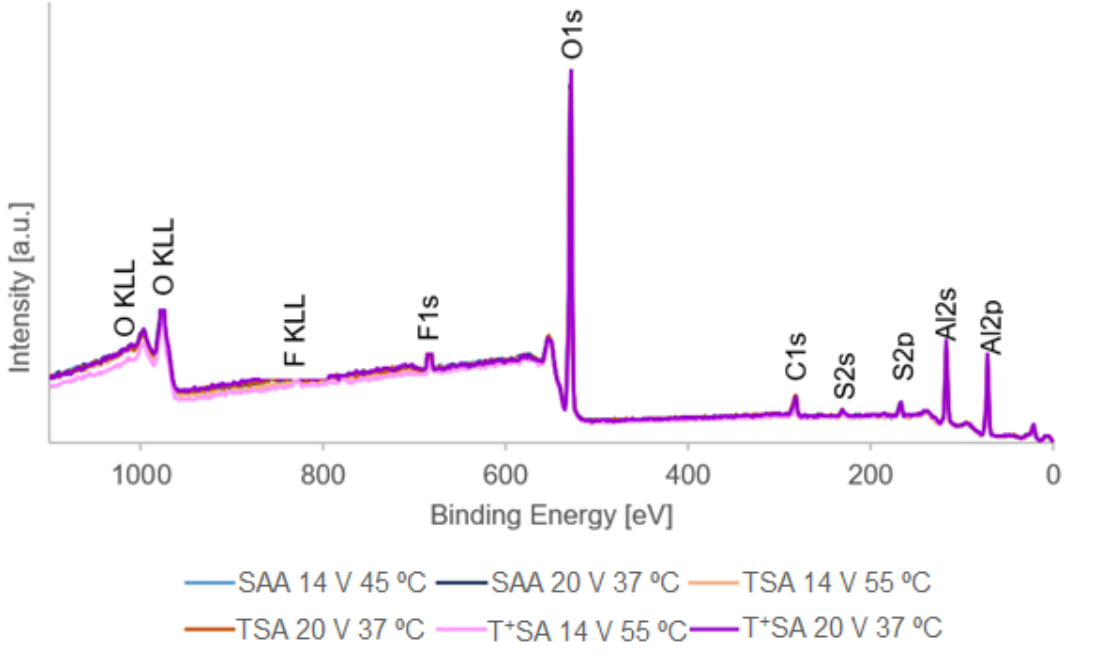
Figure 7. XPS survey scans of the six porous anodic oxide films under study.